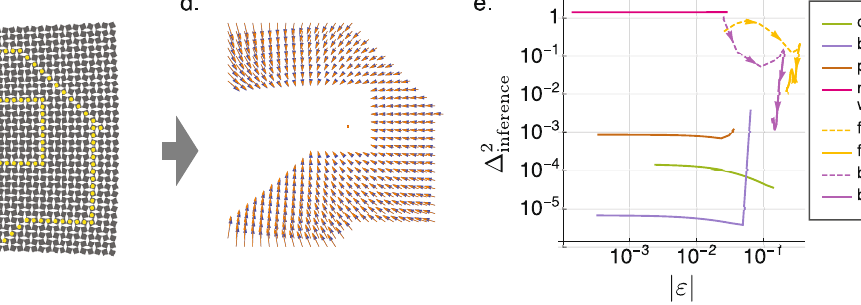
Fig. 3 Deformations are conformal and permit nonlinear prediction. a The nonlinear deformation of a three-point “ bridge ” load can be well fi t to a conformal map (magenta grid) chosen to minimize the average squared deviation between the mapped and observed displacements. b The fraction of variance unexplained Δ 2 between observed deformations and conformal fi ts in both simulations and experiments is very small, demonstrating that the conf soft deformations correspond globally to conformal maps as well as locally to pure dilations. Experimentally, the fi t is especially good in the unloading step, in which stresses arising from frictional interactions at the material boundary are able to relax. In contrast, the data for a conventional elastic material (pink) cannot be described as a conformal map. c According to the holographic property of conformal maps, the dilation fi eld on the boundary of an arbitrarily chosen (gerrymandered) region, such as the one depicted in yellow for a simulation con fi guration, should uniquely determine the deformation within the region. d Indeed, the displacements inferred from the boundary dilations (orange arrows) match closely with those observed directly in simulations (blue arrows). e The observed displacements are now compared to the conformal maps inferred in this way, and the fraction of variance unexplained plotted as Δ 2 . This demonstrates that the deformations are not merely conformal, but the precise conformal map is encoded on the inference boundary. Here, the predictions of experimental deformations are inferred from the full rectangular boundary, while predictions of FEM data are all inferred from the gerrymandered boundary points shown in ( c ) to show robustness to the choice of boundary shape. Note that the example chosen for display in ( c , d ) corresponds to the largest strain explored in the bending load, and according to ( e ) has the largest prediction error of the FEM data, and all other FEM data is predicted to even greater accuracy than depicted